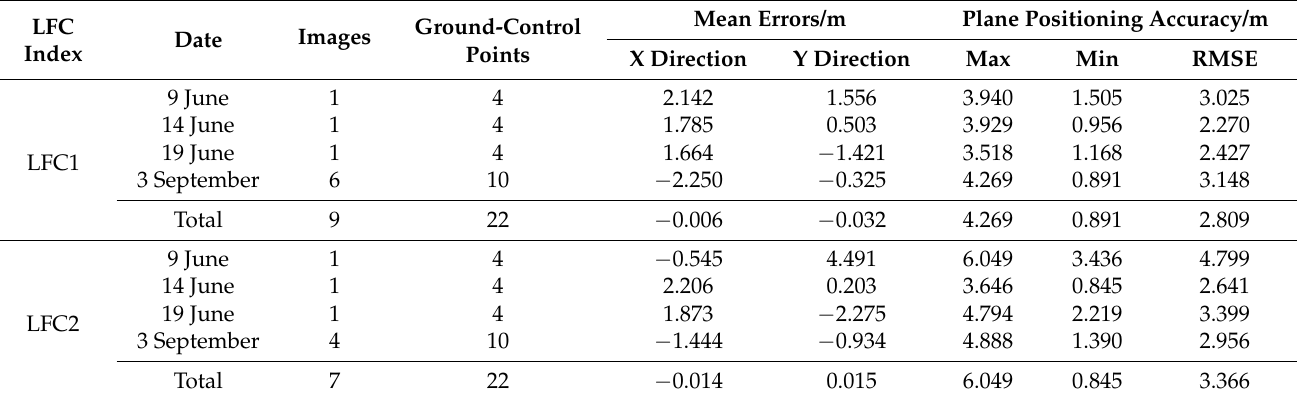
Table 5. External calibration residuals with